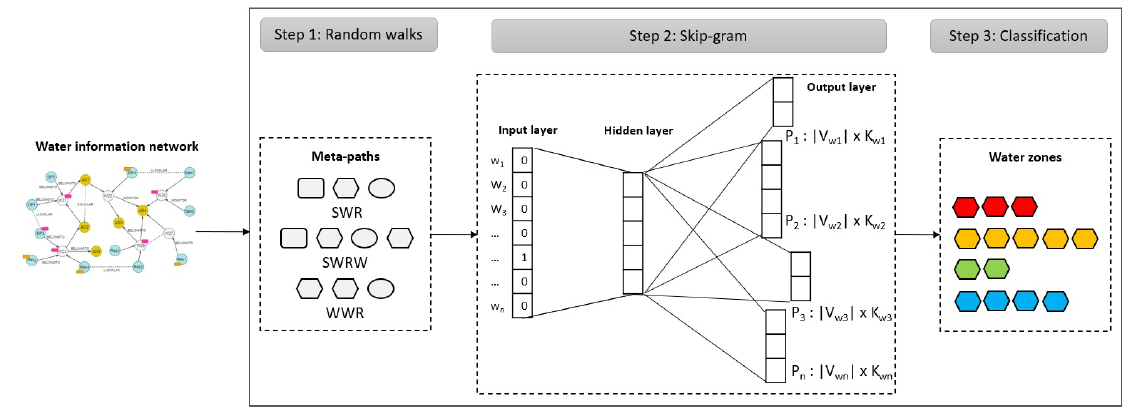
Figure 5. Incremental embedding of the water